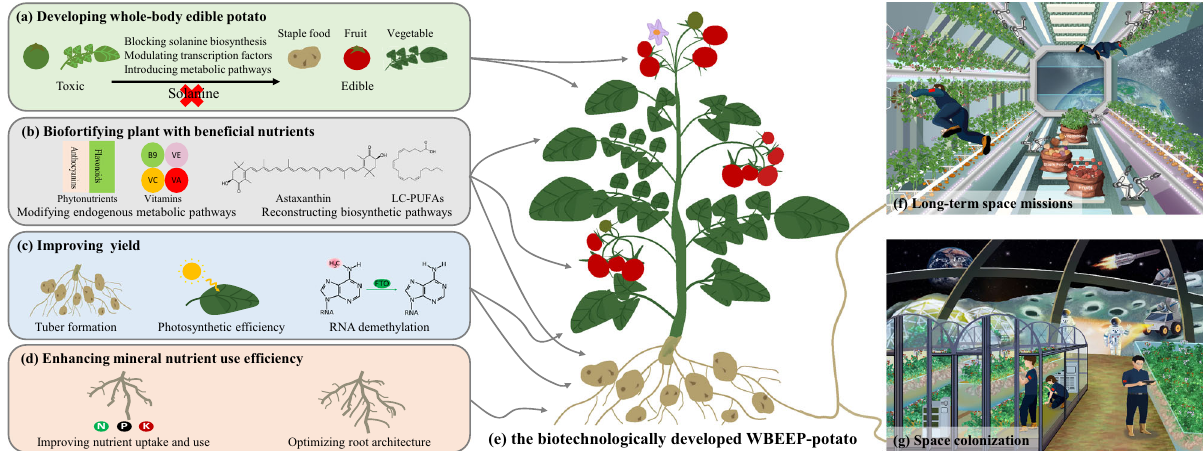
Fig. 1 Biotechnological generation of WBEEP-potato and its applications. a Developing whole-plant edible potatoes. Blocking the biosynthesis of solanine, varying its transcriptional regulation, or introducing other metabolic pathways can reduce the accumulation of solanine and make potato stems, leaves and berries edible. b Biofortifying plants with bene fi cial nutrients. Bioforti fi cation can provide phytonutrients (e.g., fl avonoids, anthocyanins, and carotenoids) by modifying endogenous metabolic pathways and astaxanthin or VLC-PUFAs (e.g., arachidonic acid) by reconstructing biosynthetic pathways. c